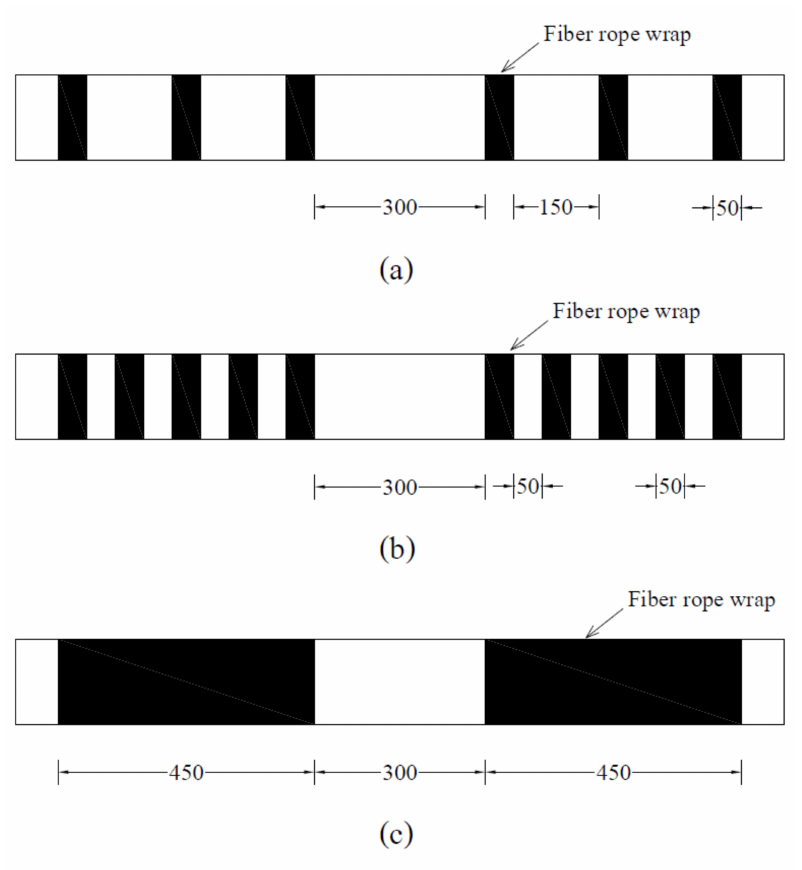
Figure 3. Strengthening configurations ( a ) Type A, ( b ) Type B, and ( c ) Type C (all dimensions in